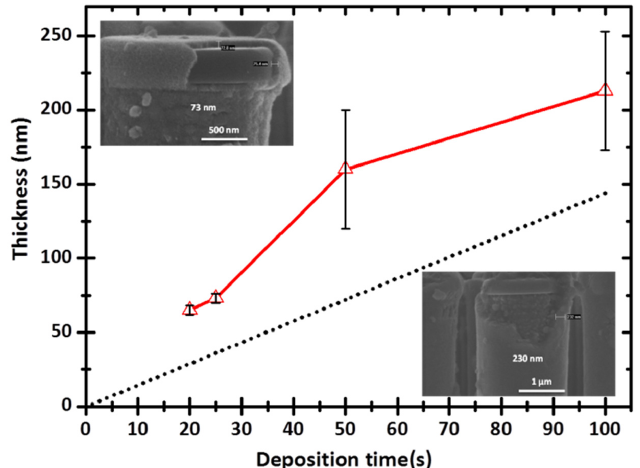
Figure 6. Theoretical thickness ( dotted line ) and experimental thickness ( full line ) vs. deposition time for EMD deposited at 4.5 mA/cm 2 on carbon coated 3D pillar arrays with an area enhancement of